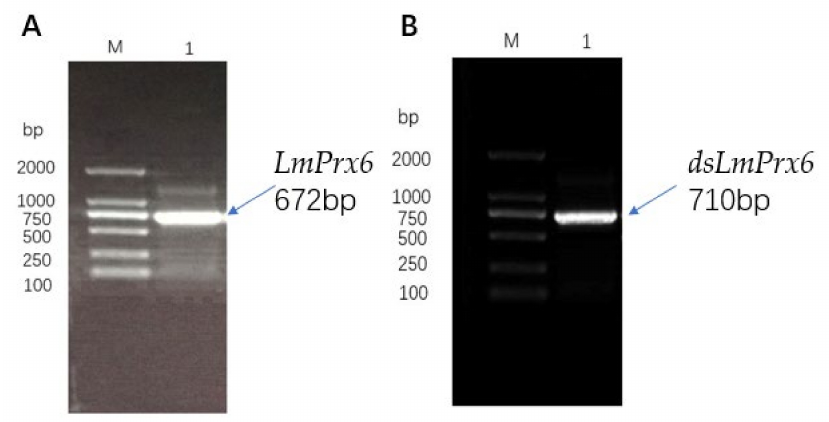
Figure 2. ( A ): Amplification of LmPrx6 (672 bp). M: DL 2000 DNA Maker; 1: LmPrx6 ; ( B ): Synthesis of dsLmPrx6 (T7 + LmPrx6, 710 bp). M: DL2000 DNA Maker; 1: dsLmPrx6